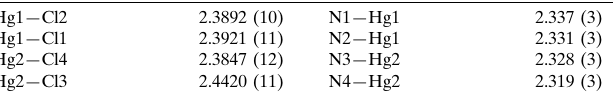
Selected geometric parameters (A ˚ , (cid:3)